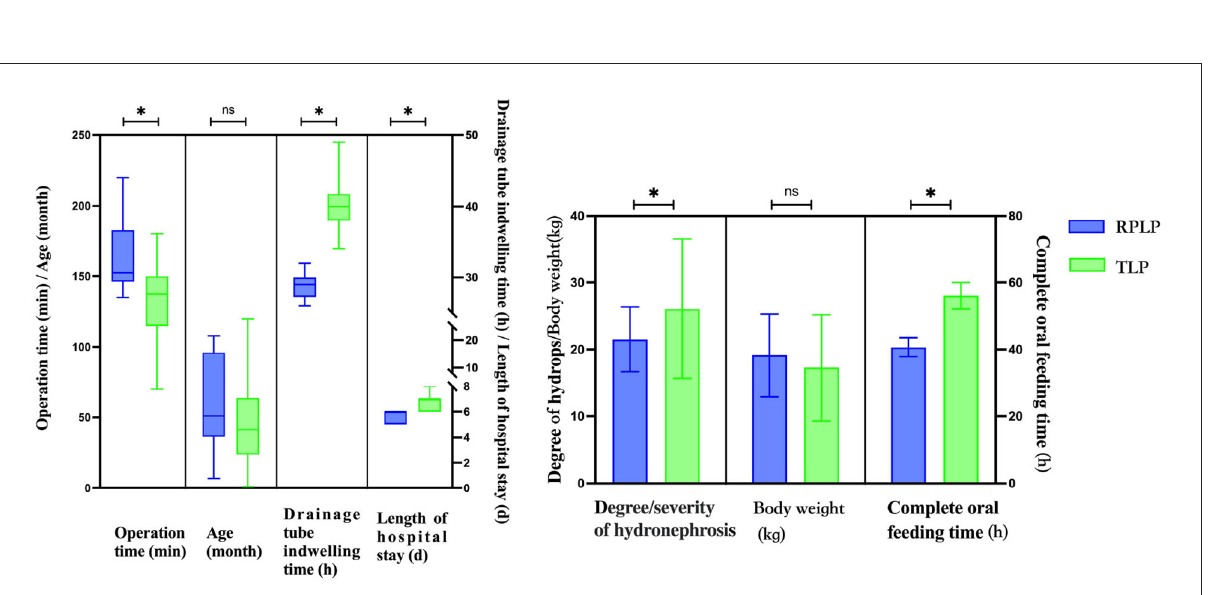
FIGURE3 Comparisons of clinical specific differences between RPLP and TLP. “ns” means no significant difference, * p <